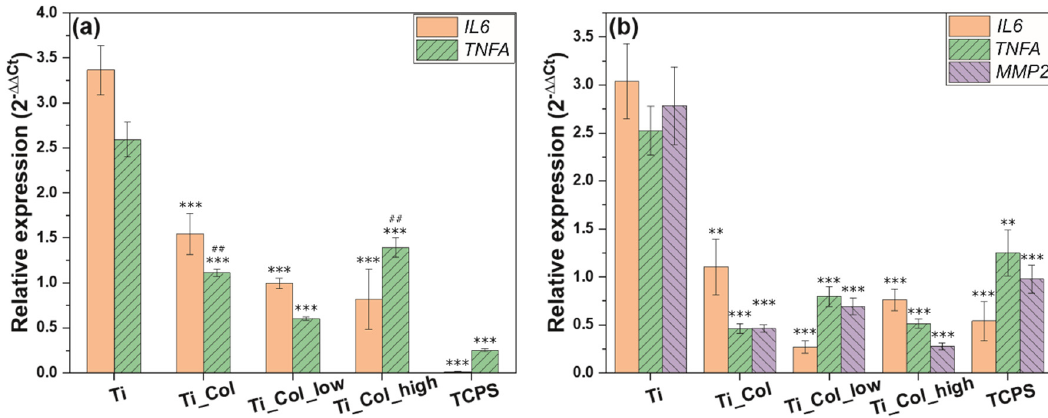
Figure 5. Relative expression of inflammatory markers in ( a ) osteoblast-like cells and ( b ) fibroblast-like cells. Ti: titanium alloy Ti6Al4V; Ti_Col: collagen-coated Ti; Ti_Col_low: collagen and low PG concentration-coated Ti; Ti_Col_high: collagen and high PG concentration-coated Ti. Error bars represent the standard error of the mean. One-way ANOVA and Bonferroni corrections for multiple comparisons. A significant level of 0.05 was used throughout the study. *Significant di ff erence between Ti control and tested samples / TCPS control. ** p < 0.01; *** p < 0.001. #Significant di ff erence between Ti_Col_low and other tested samples / Ti and TCPS controls. ## p < 0.01.